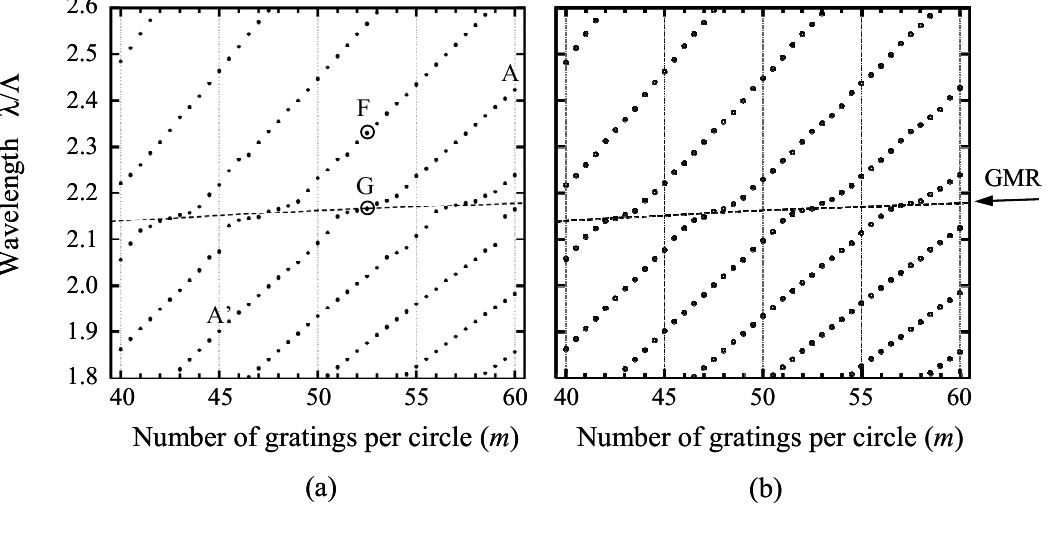
Figure 7. Calculated resonance wavelengths for various cavity sizes. The dashed line indicates the GMR wavelength of the curved RG wall. ( a ) Determined from the peaks of radiation spectra monitored outside the cavity; ( b ) Estimated by ρ is the radial position of the effective high-index eff